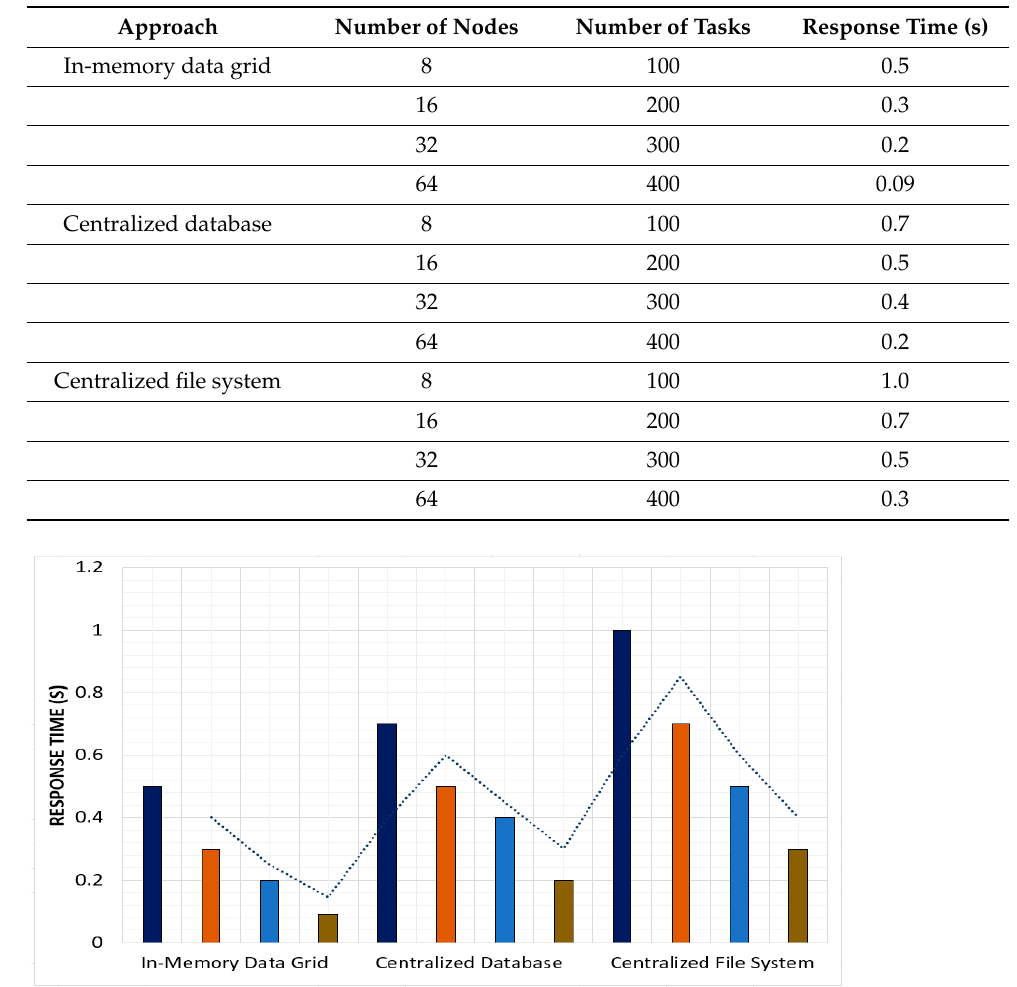
Table 7. Comparison of response time for different approaches.